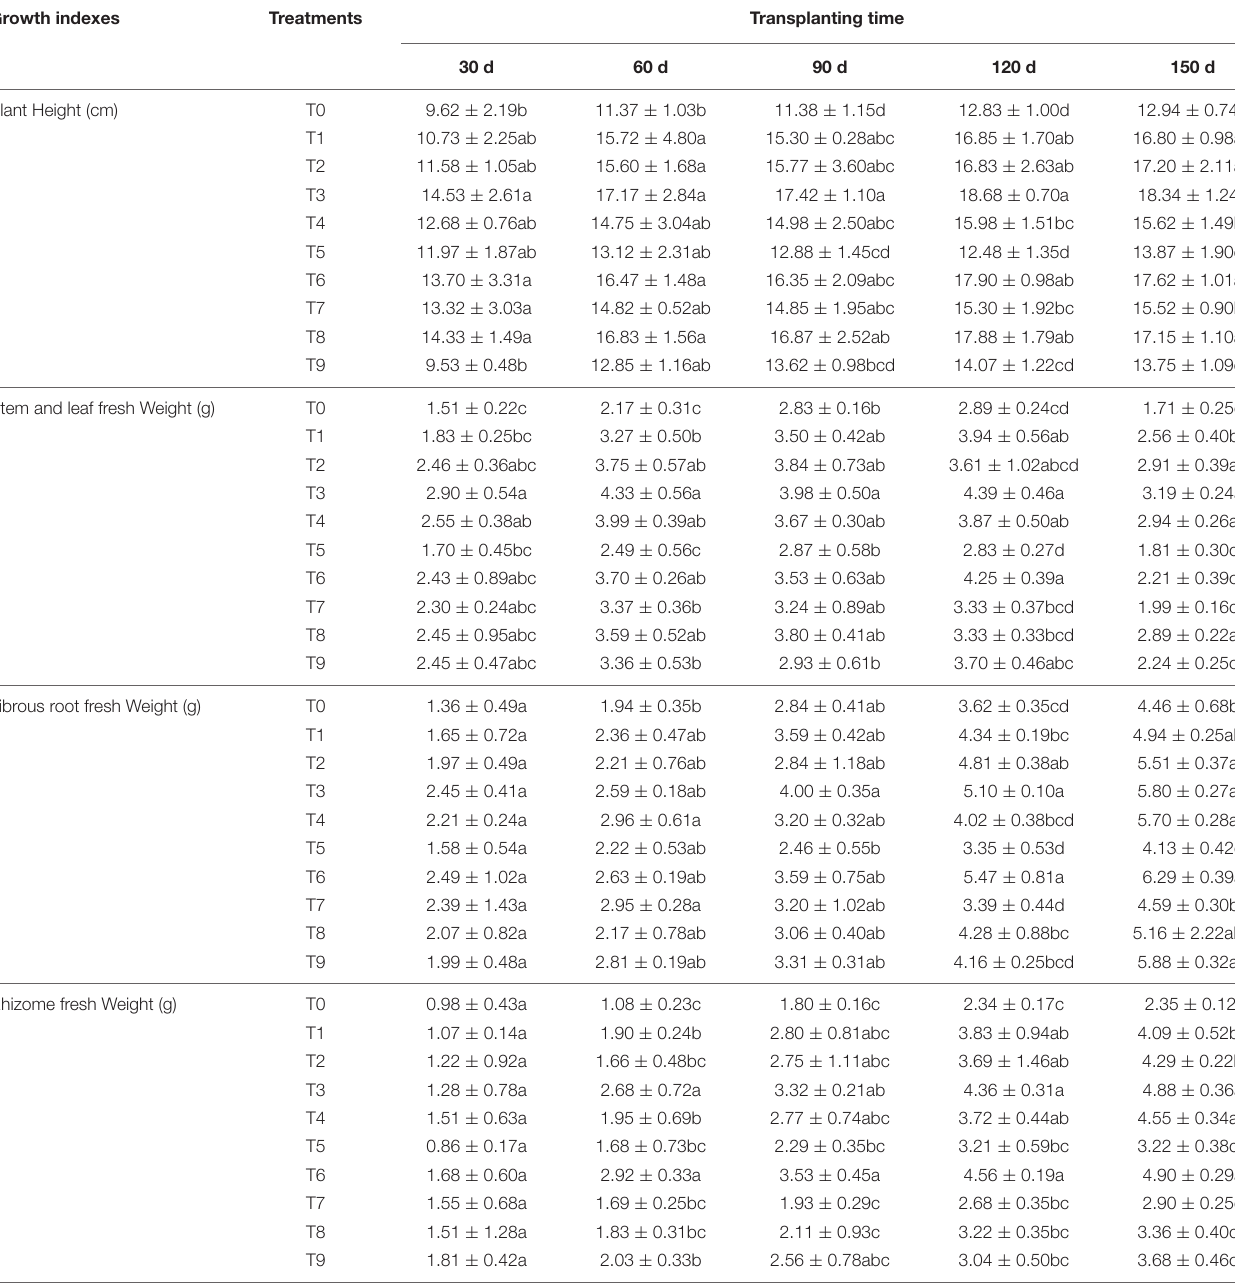
TABLE 3 | The effects of different NPK combinations on the growth indexes of Atractylodes chinensis. Growth